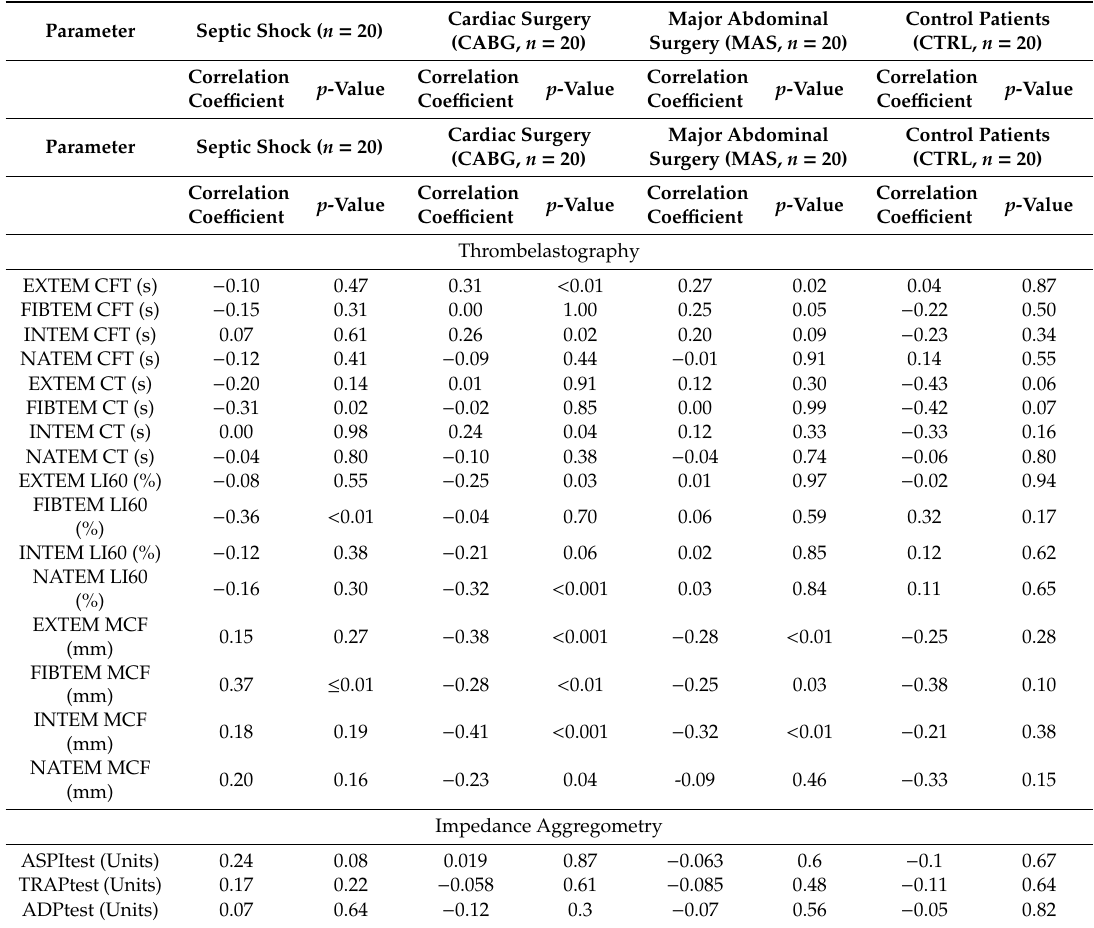
Table 3. Correlation of NETs to coagulatory and inflammatory